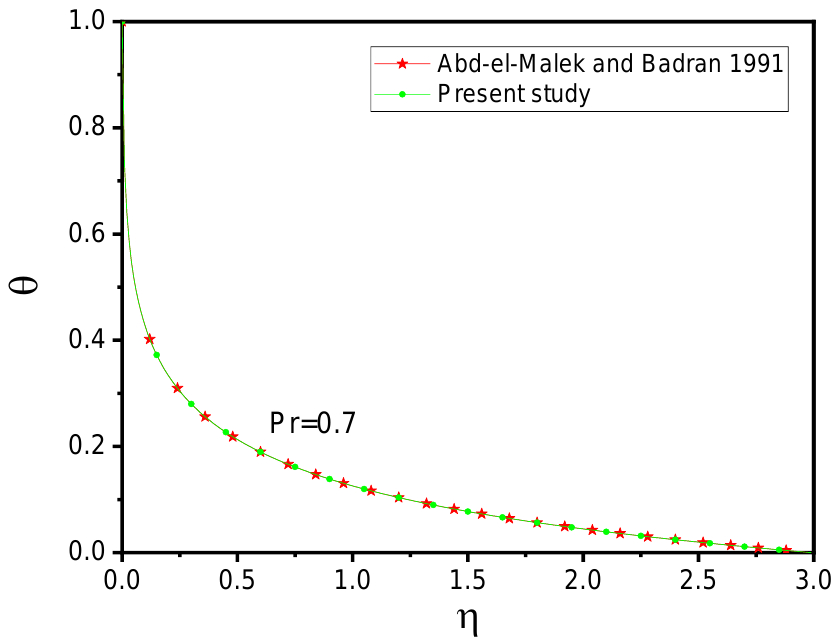
Figure 3. Comparison with [37] of θ for Pr = 0.7 with β = Mn = Ec = Nr = φ =